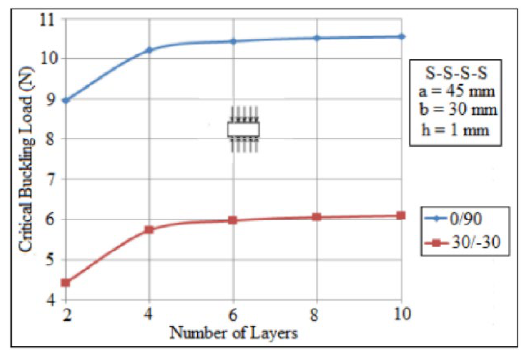
Figure 14. Critical buckling load against number of layers.